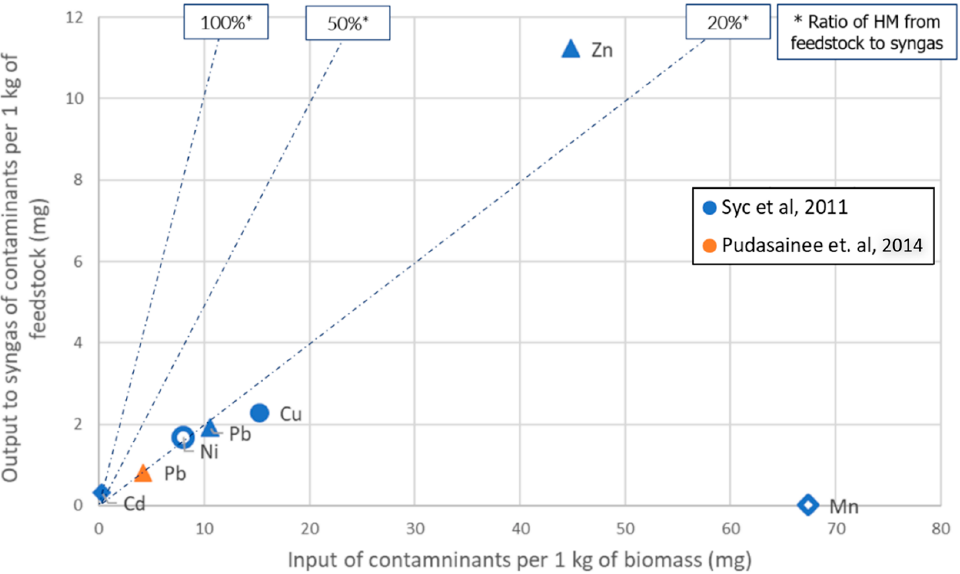
Figure 5. Gasification: Output to syngas vs. input with feedstock of HM species. Focus on low- input loads. Adapted from